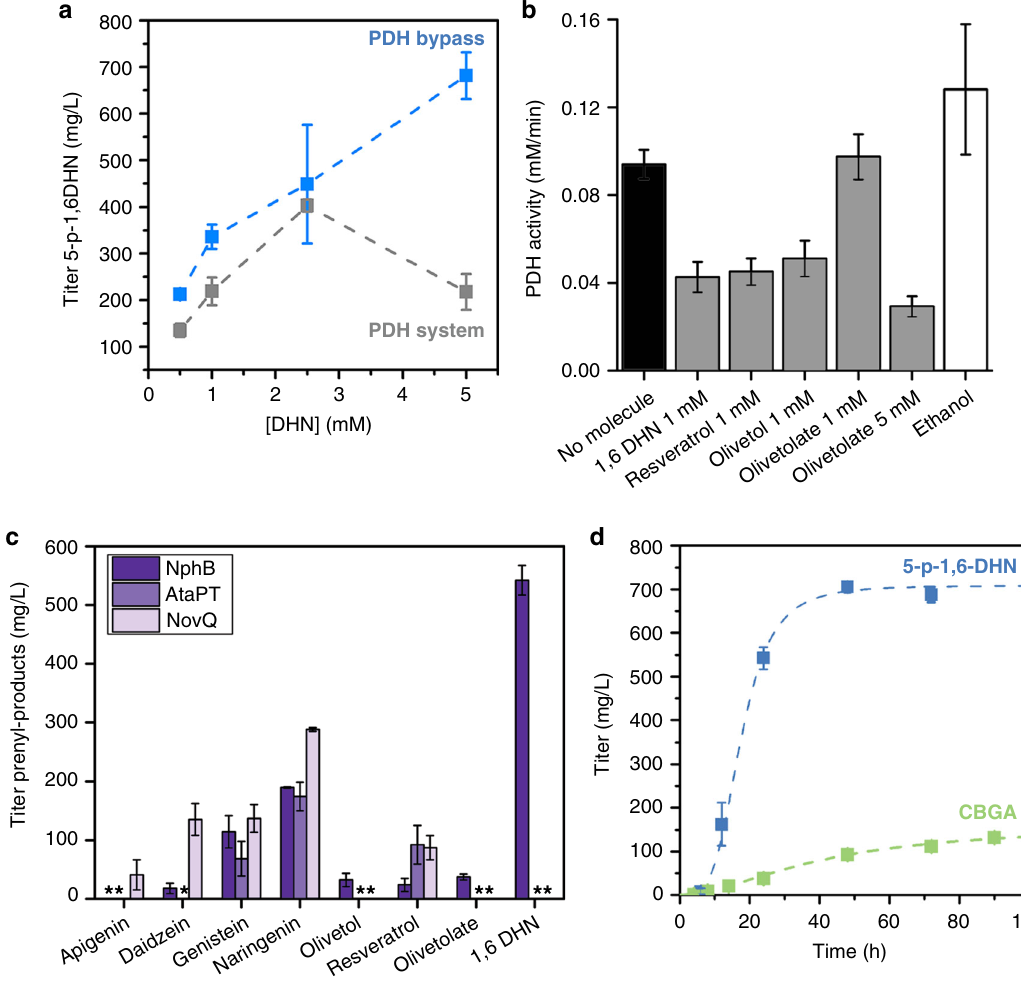
Fig. 2 Development of a PDH bypass for the prenylation of aromatic polyketides. a The comparison of the fi nal titers achieved with the full pathway utilizing PDH (PDH system-gray trace) and the PDH bypass system (blue trace) at different concentrations of 1,6 DHN. (biological replicates, n = 3). b The activity of pyruvate dehydrogenase ( E. coli PDH) measured in the presence of various aromatic polyketides and 2% ethanol (vehicle) (biological replicates, n = 3). c Various aromatic substrates were added to the pathway with either NphB, AtaPT, or NovQ prenyltransferase (biological replicates, n = 3). The result is a variety of C5 and C10 prenyl-natural products. (* Indicates titer not determined). d Production of 5-prenyl-1,6 DHN (blue trace) over time compared to a separate reaction to produce CBGA (green trace). Both reactions utilized the PDH bypass and WT NphB (biological replicates, n = 3). All error ranges re fl ect the standard deviation. Source data for Fig. 2a – d are provided as a Source Data fi